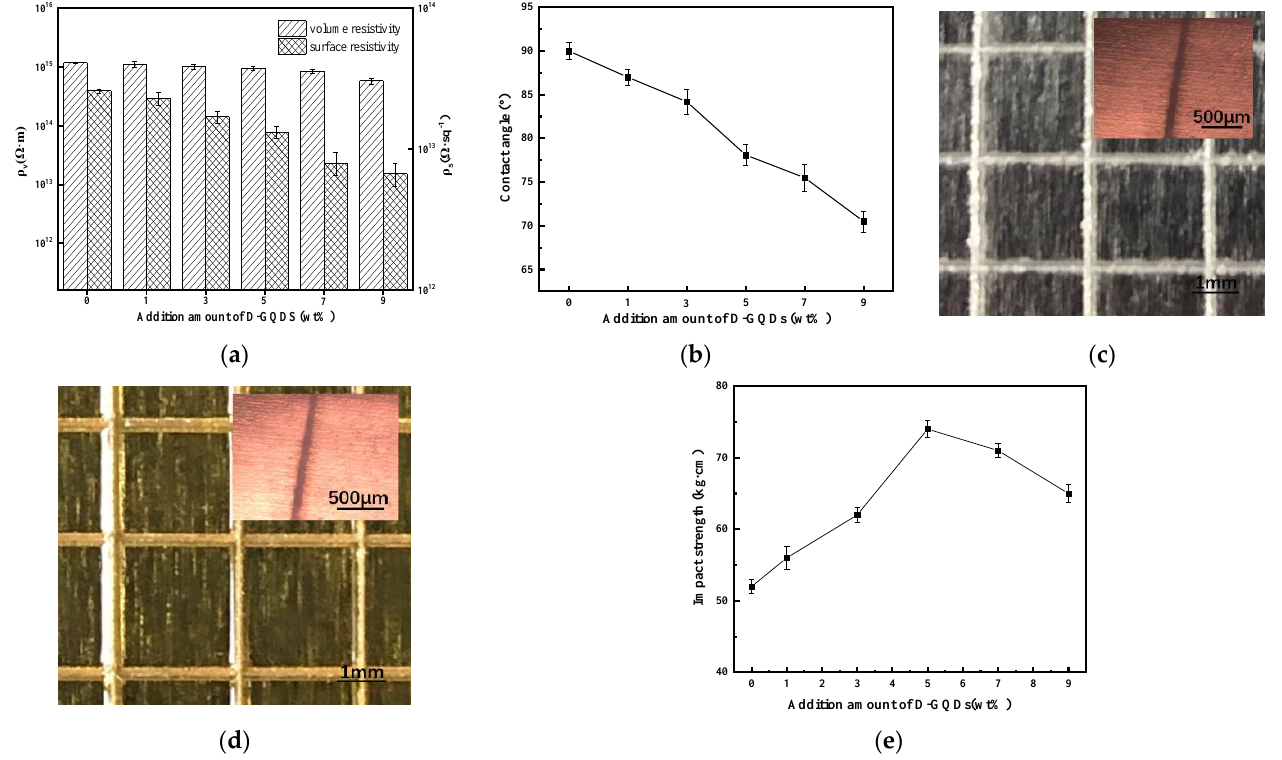
Figure 4. ( a ) The surface resistivity and volume resistivity and ( b ) contact angles of the DG-ER sheet. Also shown are photographs of the surface of the notches in the ( c ) ER coating (inset: SEM image) and ( d ) DG-ER coating (inset: SEM image), and ( e ) The impact strength of DG-ER coating.